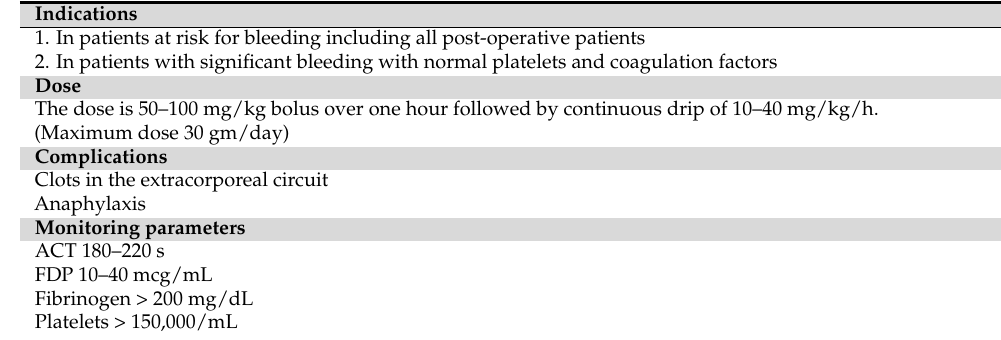
Table 4. Aminocaproic acid indications, dose, complications & monitoring